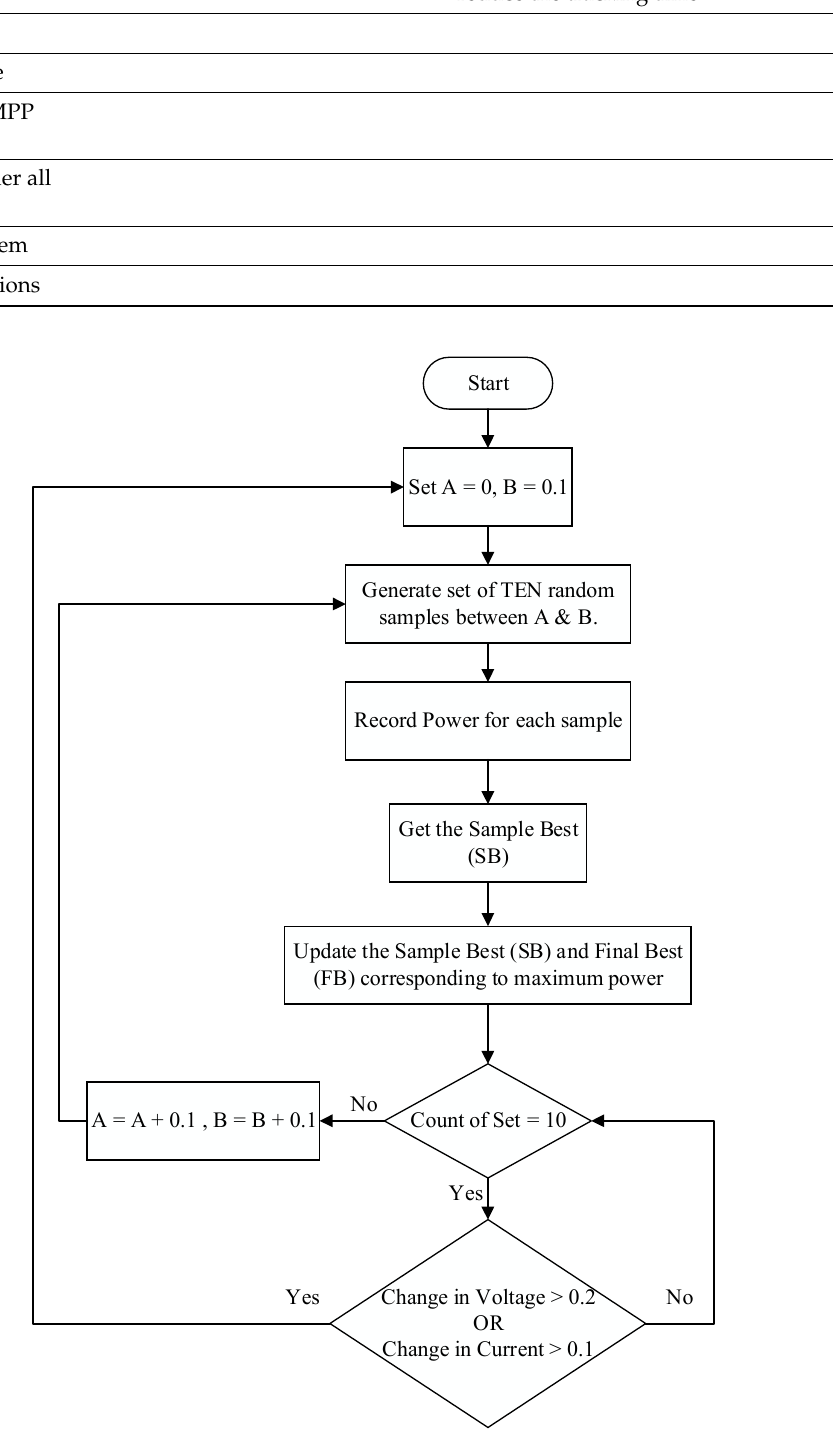
Figure 2. Flowchart of the ten check algorithm.